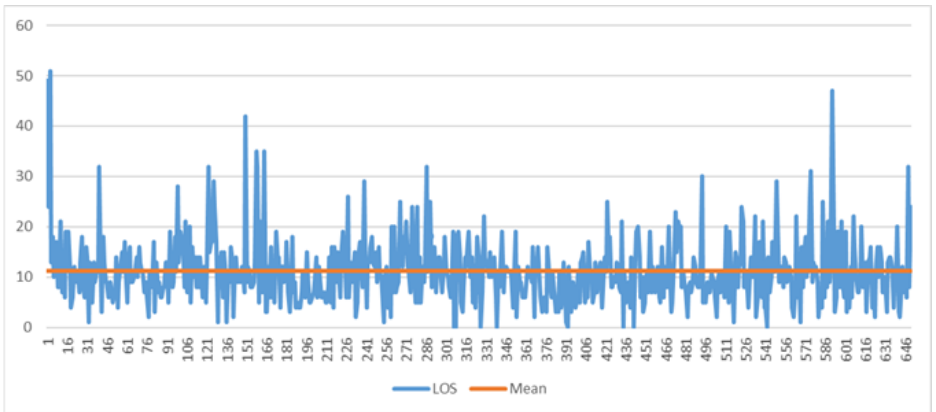
Figure 5. The run chart of total LOS for stroke patients before COVID-19. The orange line indicates the average value of 11.19 days.